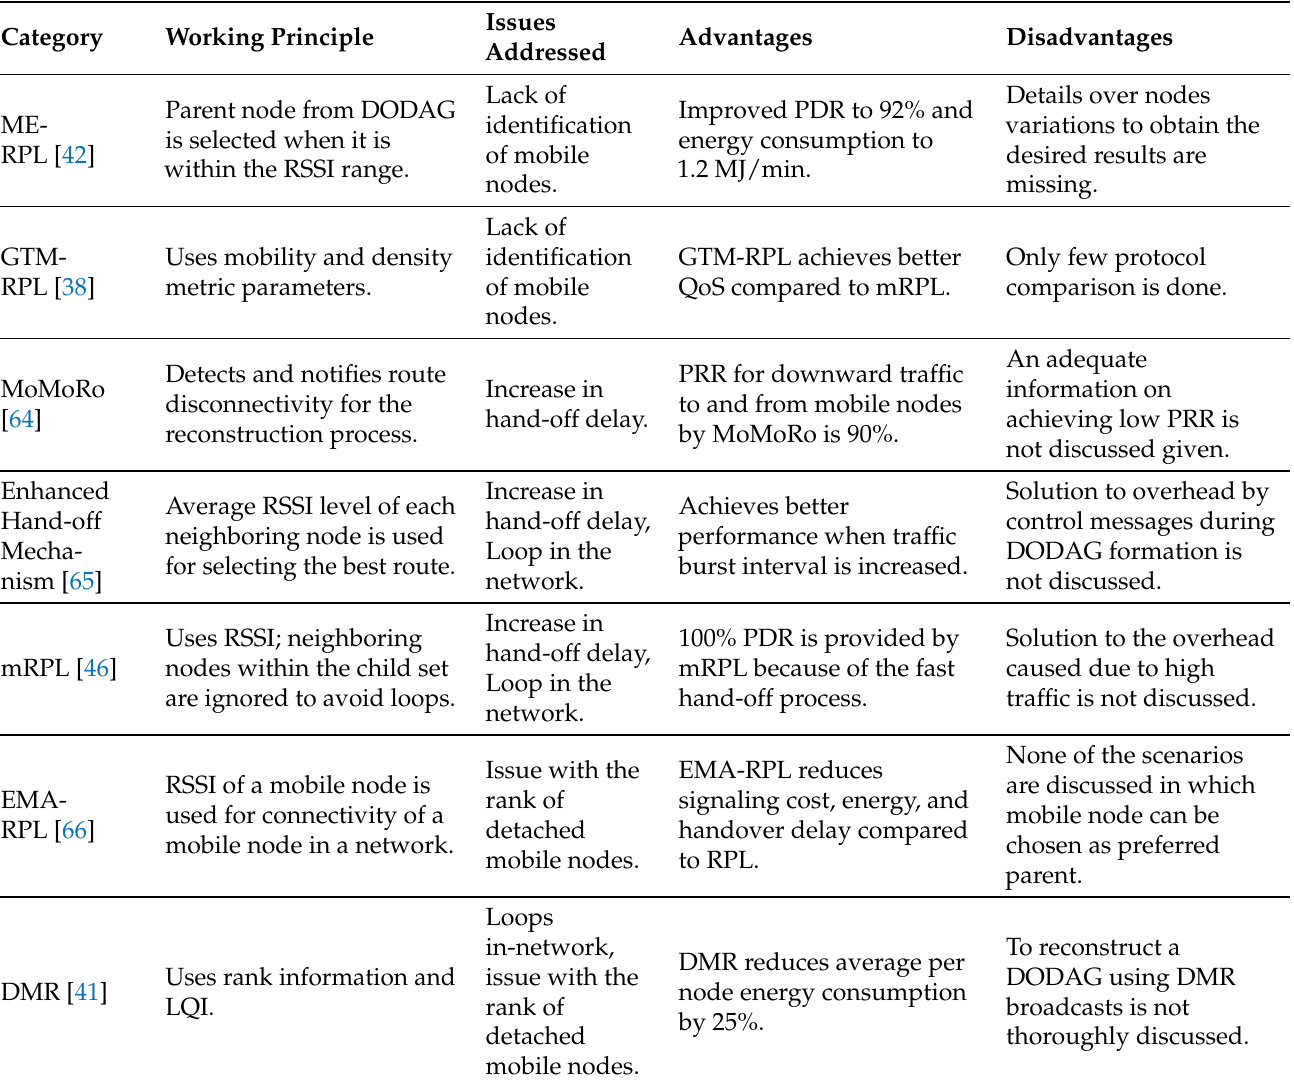
Table 3. Summary of RSSI-based